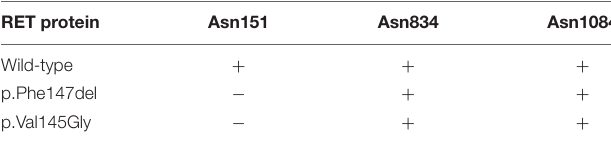
TABLE 1 | The glycosylated sites predicted by GlycoEP for RET proteins with wild-type, and p.Phe147del and p.Val145Gly